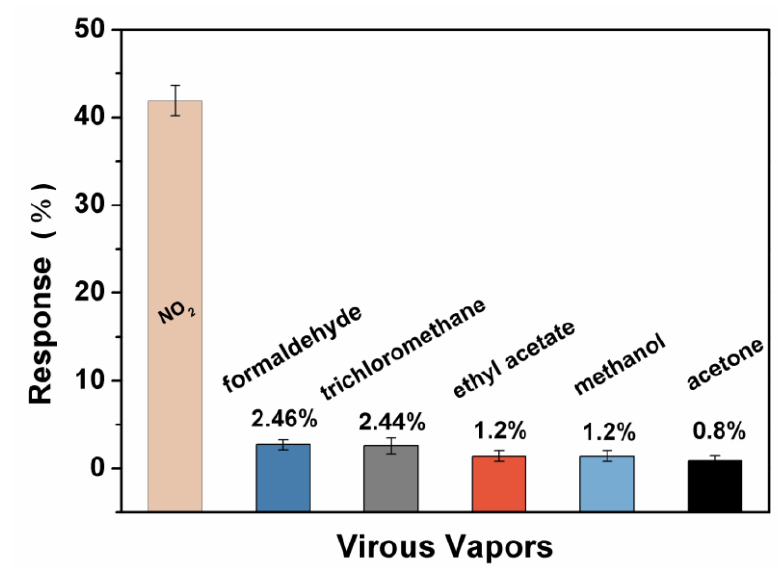
Figure 12. The selectivity of E 0 -based sensor.